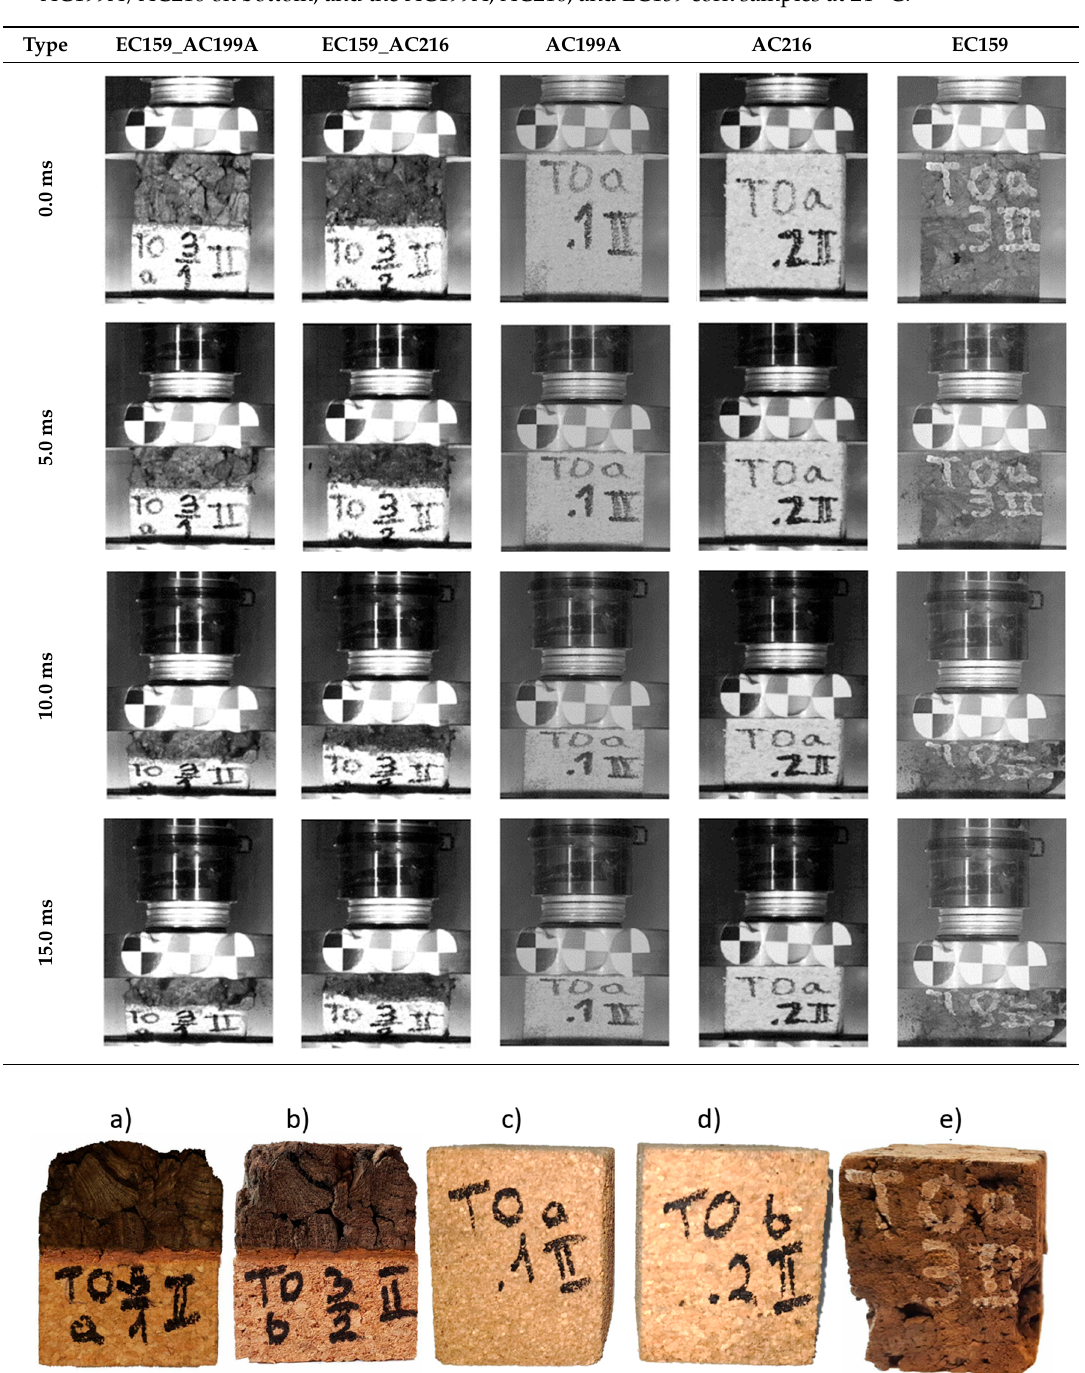
Table 2. Time sequence of 100 J impact for two different cork sandwiches: EC159 is shown on top and AC199A/AC216 on bottom, and the AC199A, AC216, and EC159 cork samples at 24 °C.